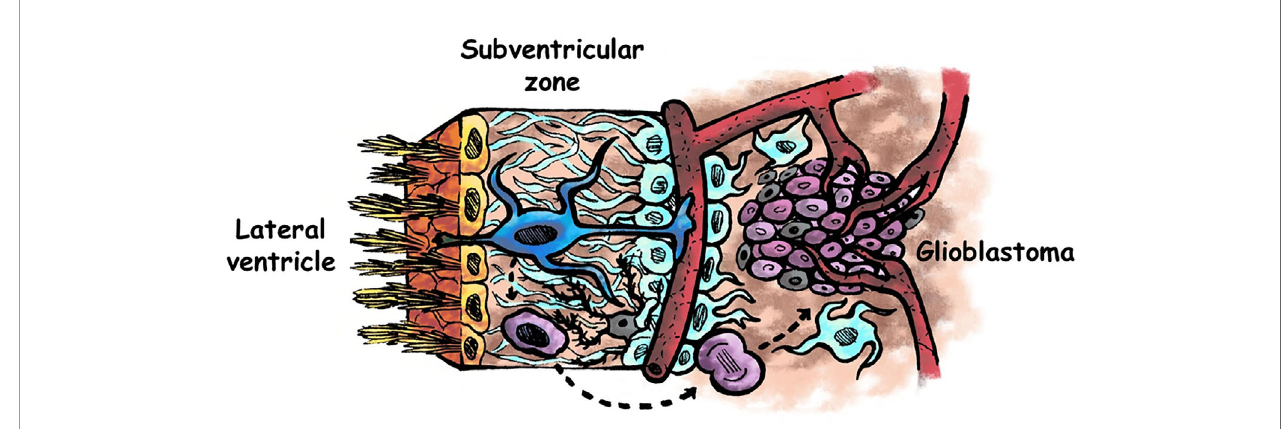
FIGURE 1 | Schematic representation of the human adult subventricular zone and an adjacent glioblastoma. Ependymal cells are represented in yellow, neural stem cells in blue, astrocytes in pale blue, microglia in grey, glioma stem cells in purple, and other type of glioma cells in pale purple. Neural stem cells of the subventricular zone may acquire driver mutations that generate glioma stem cells, which divide to form the tumour mass. Factors present in the cerebrospinal fl uid fl owing the lateral ventricles may intervene in the genesis and/or in the progression of glioblastomas. Modi fi ed from